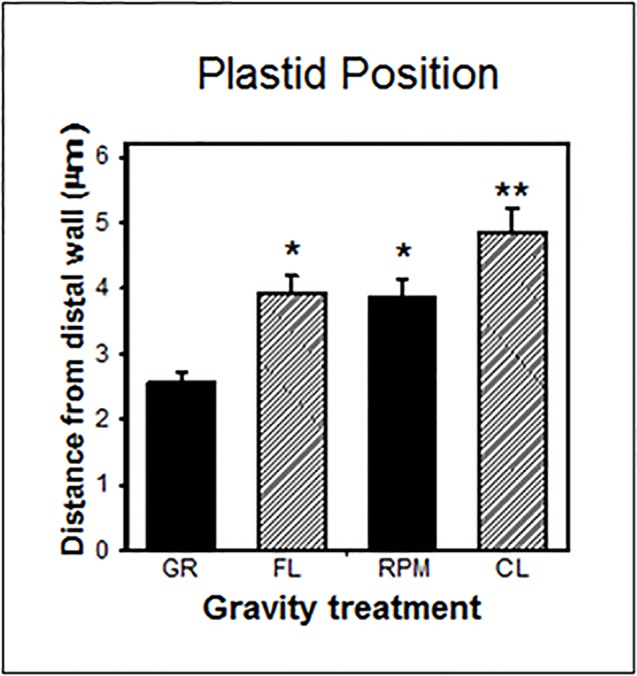
Plastid position in central columella cells of root tips of Arabidopsis seedlings grown on the ground (GR), during spaceflight (FL), on a random positioning machine (RPM), and on a clinostat (CL). These cells are involved in gravity perception (Kiss, 2000). There is no statistical difference (P > 0.05) between the FL and RPM samples as indicated by *, while the FL samples are significantly different (P < 0.05) from the CL specimens as indicaated by ** and determined by an ANOVA followed by a Tukey post-test.